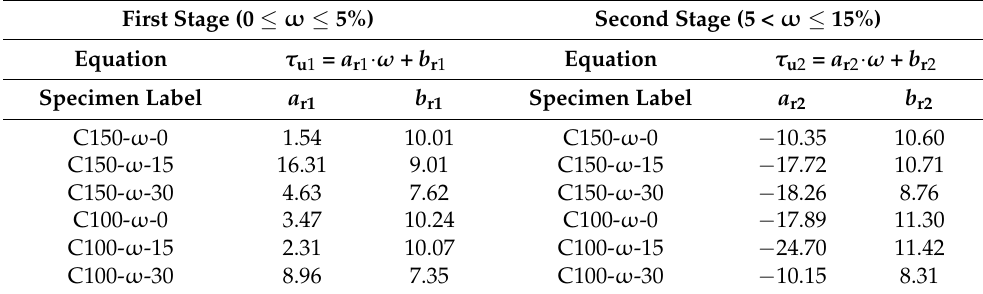
Table 4. The ultimate bond strength as a function of stirrup corrosion rate ω .